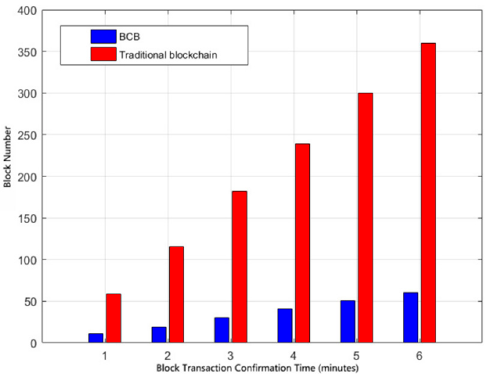
Figure 7. Comparison of block transmission performance.